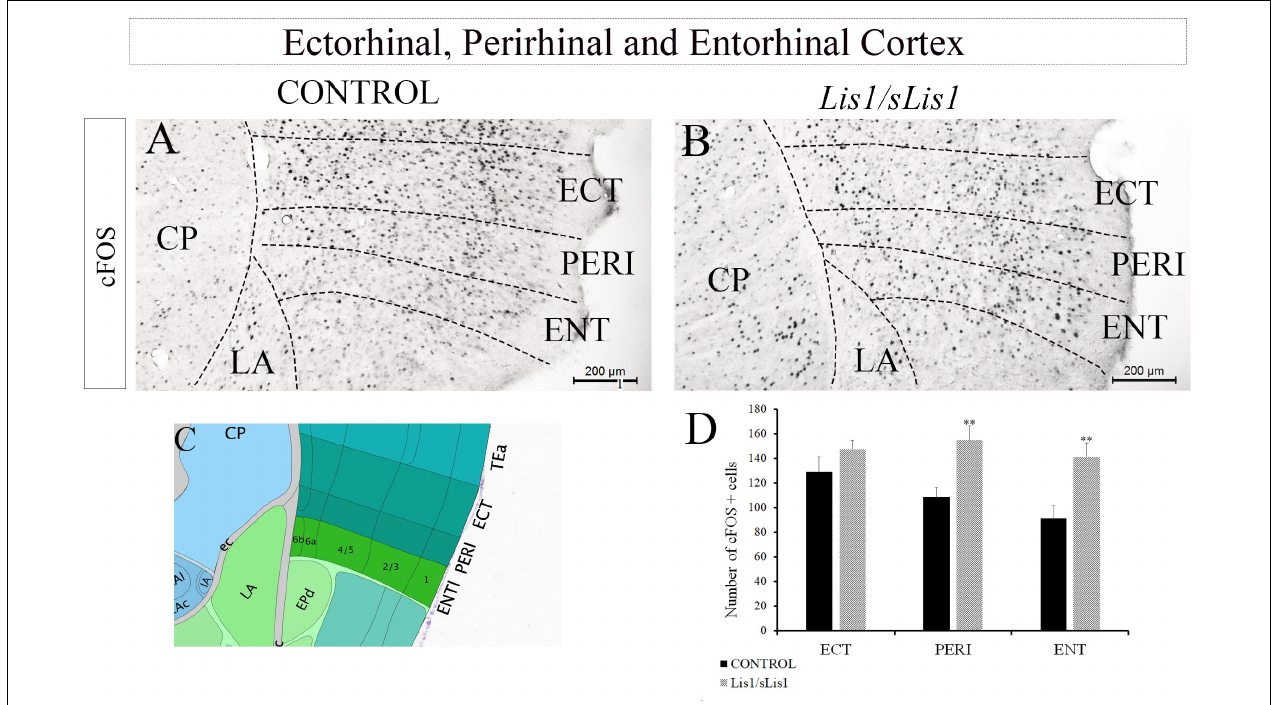
FIGURE 6 | Analysis of cells expressing cFOS in other hippocampus-related cortical regions. (A,B) The entorhinal, perirhinal, and ectorhinal cortices were assessed. The number of cells positive for cFOS was quantified in these areas and the perirhinal and entorhinal areas of the Lis1/sLis1 mutant mice presented a larger number of cells expressing cFOS (B) than the controls (A) . No significant differences in the ectorhinal cortex were detected between the Lis1/sLis1 mutant mice and controls. (C) The image was taken from the Allen Brain Atla s showing the approximate area of panels (A,B) . (D) The histogram shows these results in the areas analyzed (ECT; PERI, and ENT). Scale bar is 200 µ